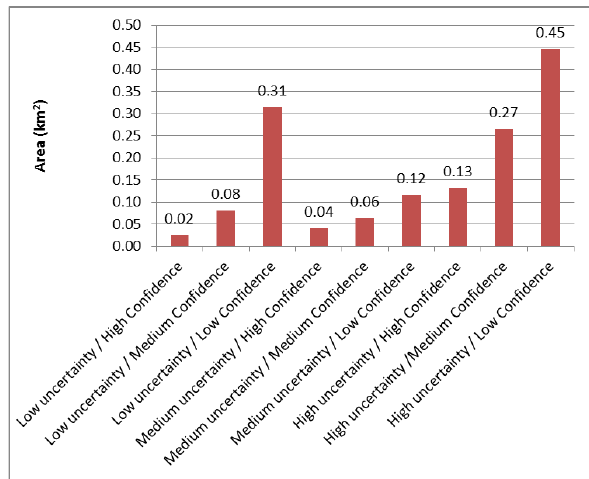
Figure 10. Area in km2 of the region classified as Herbaceous Vegetation belonging simultaneously to the indicated levels of uncertainty and confidence